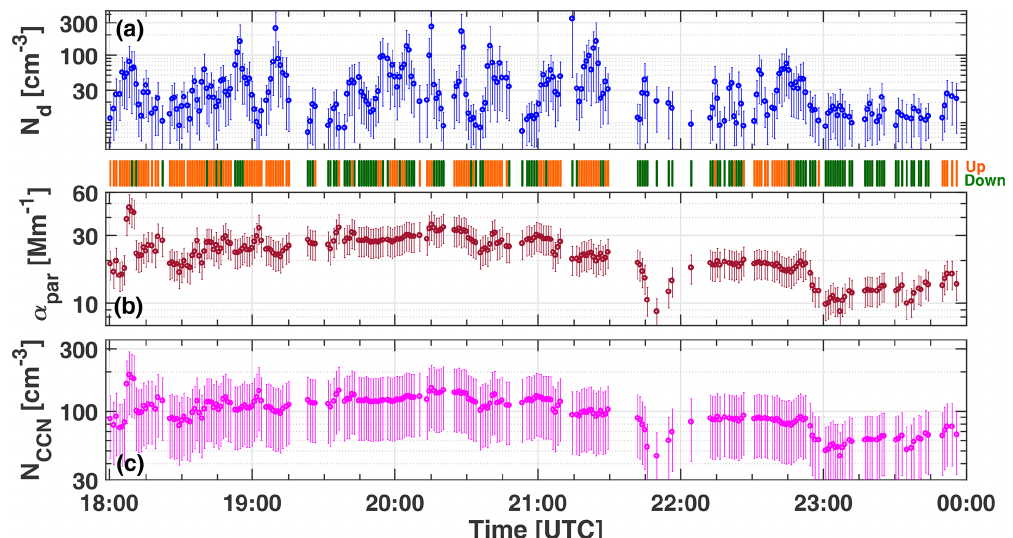
Figure 9. (a) Cloud droplet number concentration N d for the height of z ref = z bot + 75m within the stratocumulus layer shown in Fig. 8. Below a , the vertical wind indicator (orange: updraft, green: downdraft) is shown. (b) Particle extinction coefficient α par (mean value for the height range from 375 to 600m below the cloud base). (c) CCN concentration N CCN obtained from the extinction coefficient (in b ) by using the marine conversion parameters (Sect. 6 in Part 1) (Jimenez et al., 2020). Temporal resolution is 1min. Error bars indicate the uncertainty